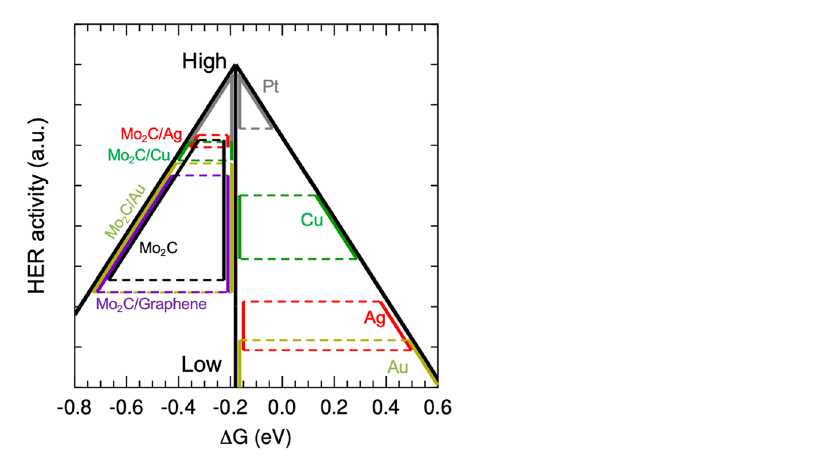
Figure 3. The HER activity for the catalysts Pt (gray), Cu (green), Ag (red), and Au (dark yellow). The HER activity of the Mo 2 C on the corresponding substrates are shown. The vertical black line at − 0.18 eV represents the optimal value, and the activity of the catalysts are compared on the vertical line. A higher position on the line represents higher HER